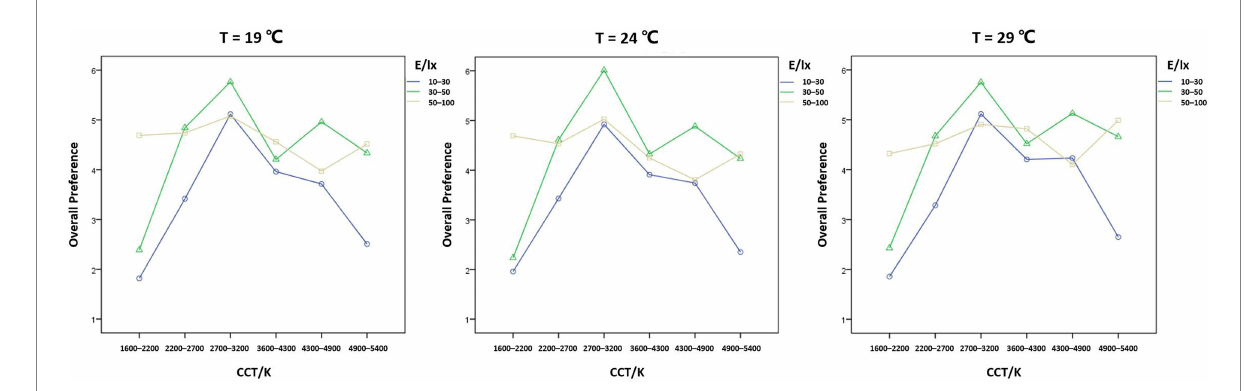
FIGURE 5 Interaction trend of CCT, illuminance, and experimental temperature on the overall preference